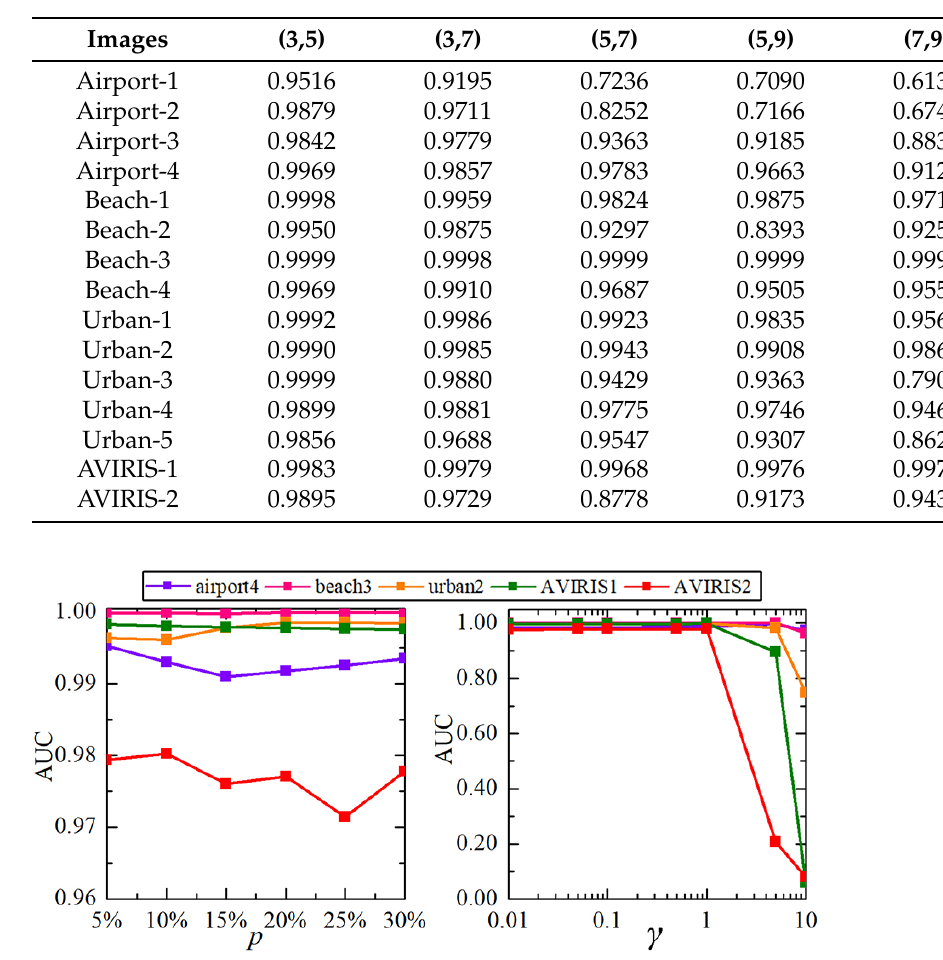
Table 3. Effects of dual window size ( w in , w out ) on detection performance.